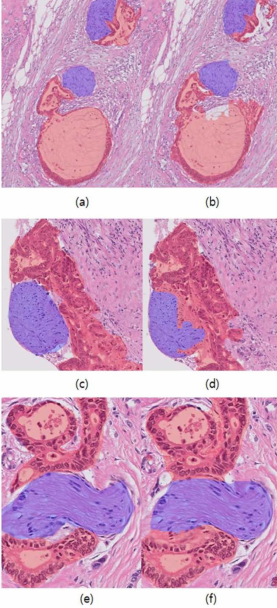
Figure 2. Three representative regions of extracted PNI with ground truths ( a , c , e ) and the corre- sponding pixel-wise predictions ( b , d , f ). Based on the spatial arrangement of the tumors (red) and the nerves (purple), a nerve close to a tumor was classified as